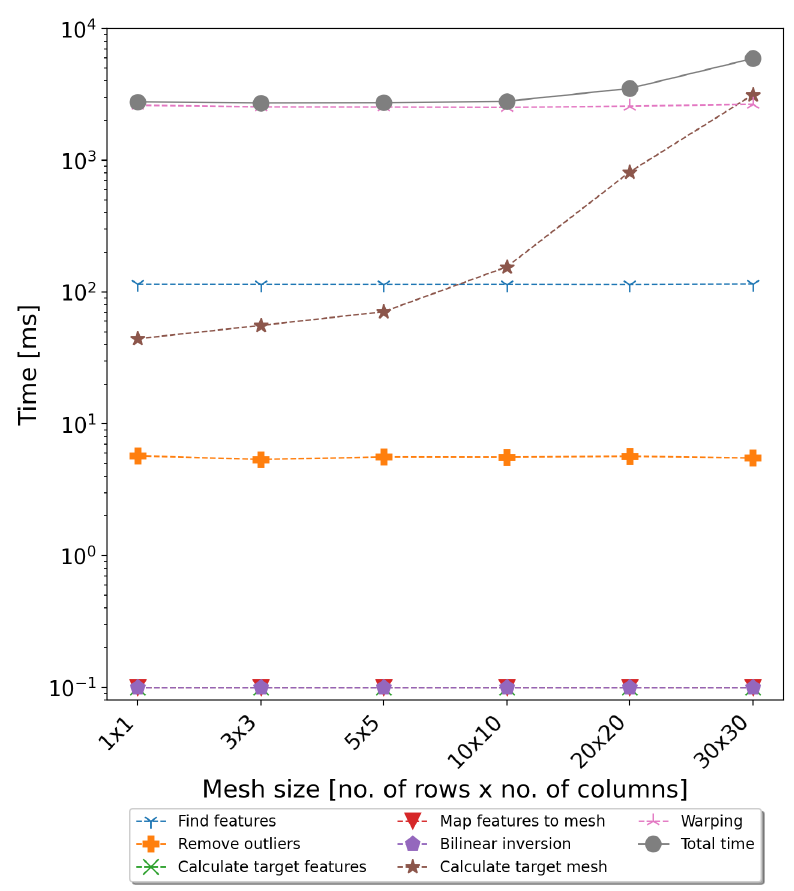
Figure 3. Average execution time for the rectification algorithm steps (CPU version) for various mesh